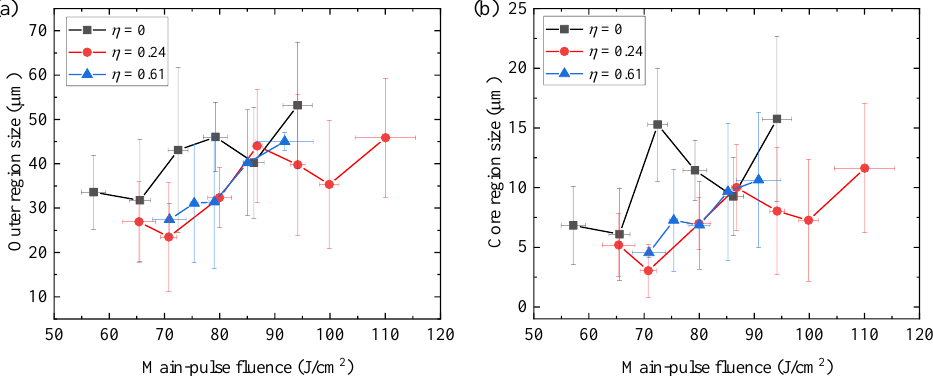
Figure 7. Size distributions of ( a ) the outer and ( b ) core regions of the damage sites on the pre-pulse fluence for η = 0 (single-pulse), η = 0.24 and η = 0.61.